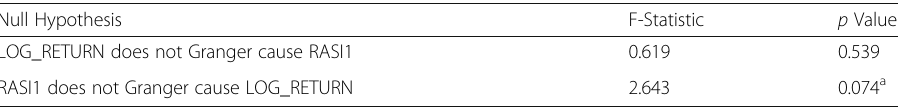
Table 4 Granger causality